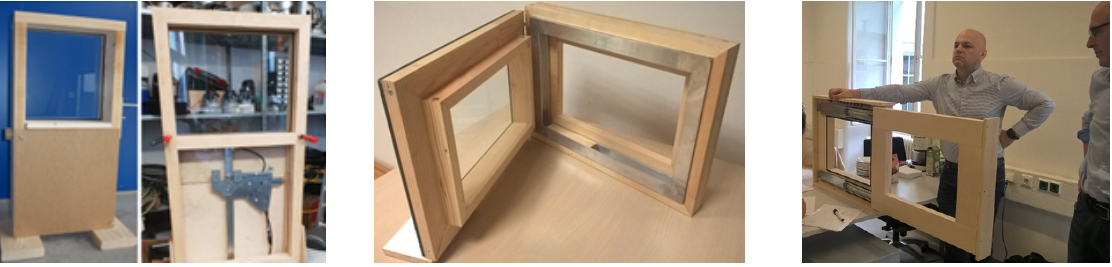
Figure 6. Early functional prototypes for sliding windows and turn